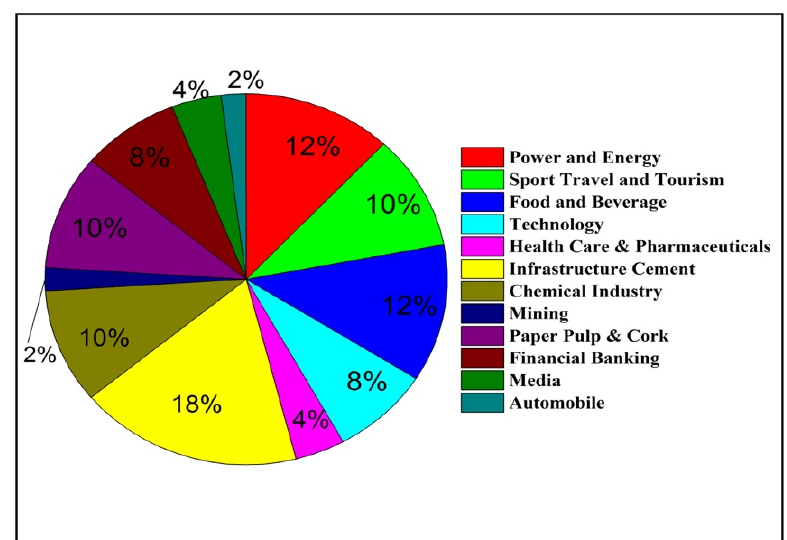
Figure 2. The share of industries targeted in our survey.